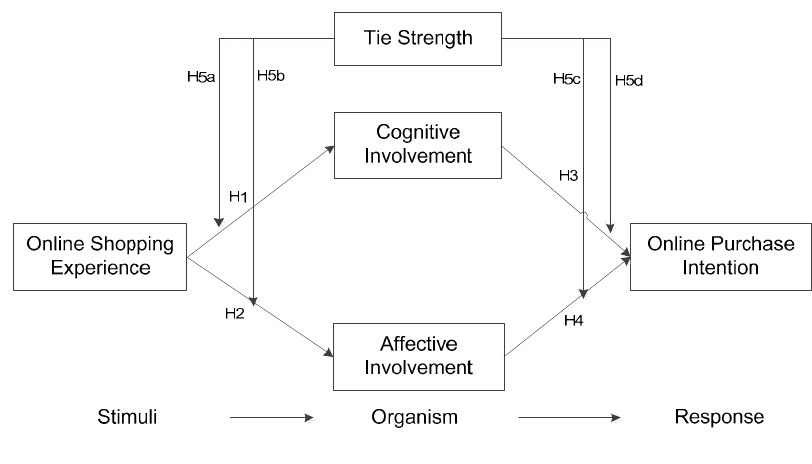
Figure 1. Research Figure 1. Research model.